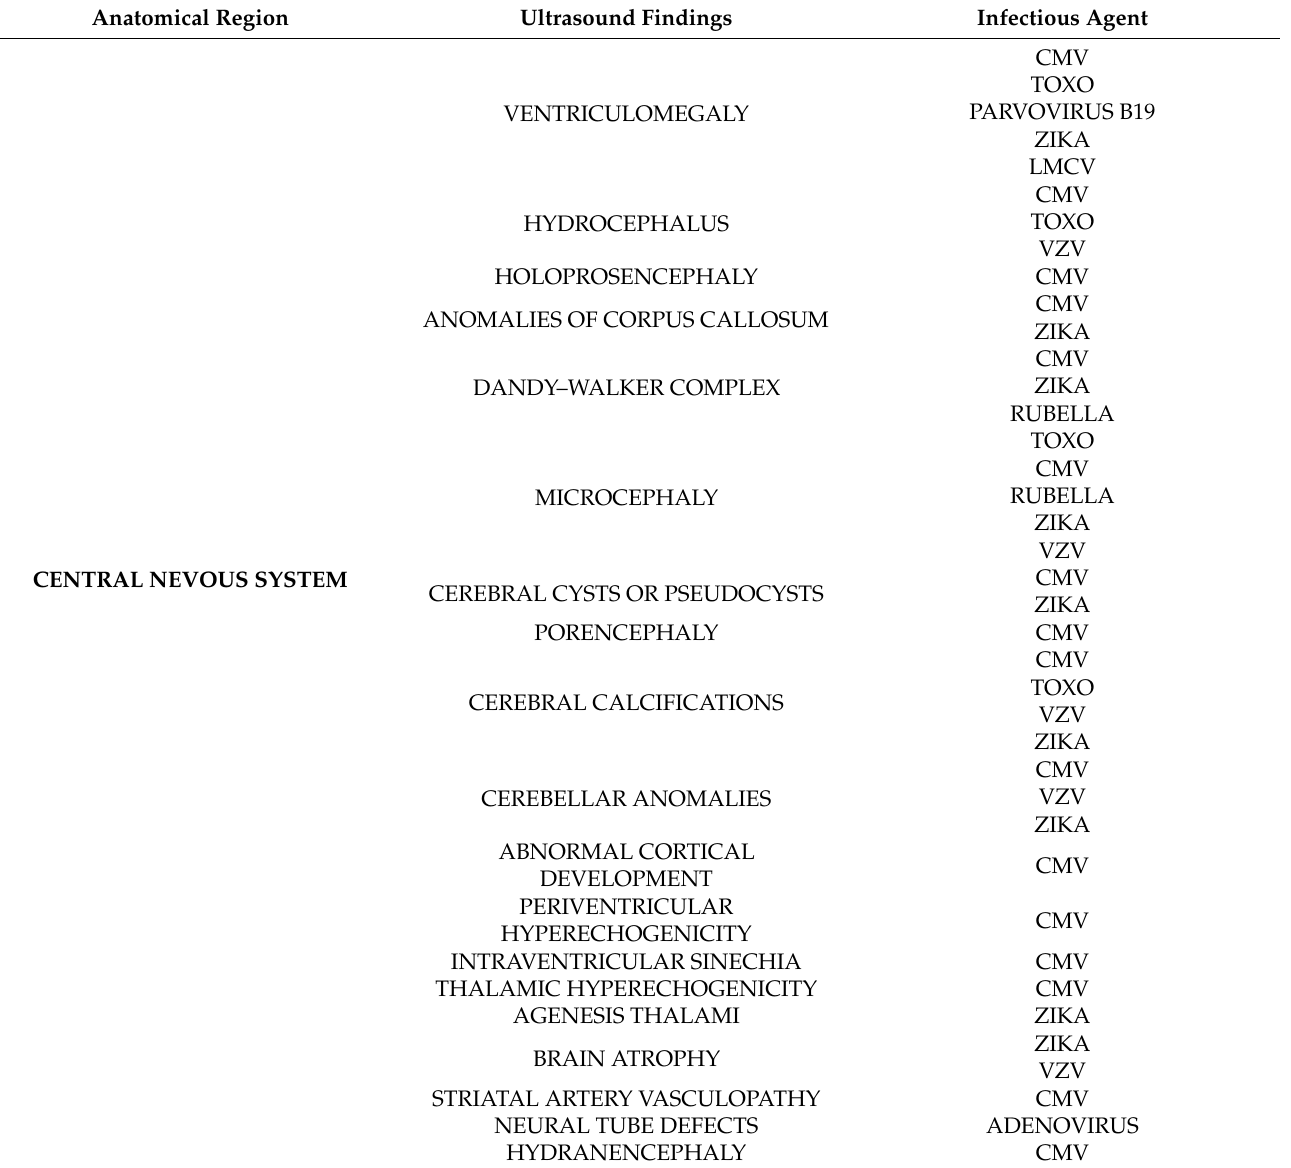
Table 1. Ultrasound fetal anomalies and possible association with infectious